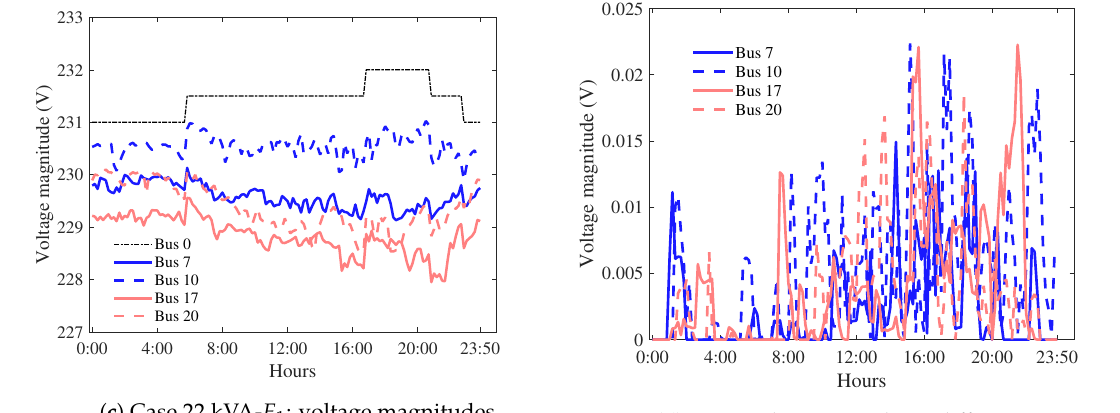
( d ) Case 22 kVA- E 1 : voltage differences